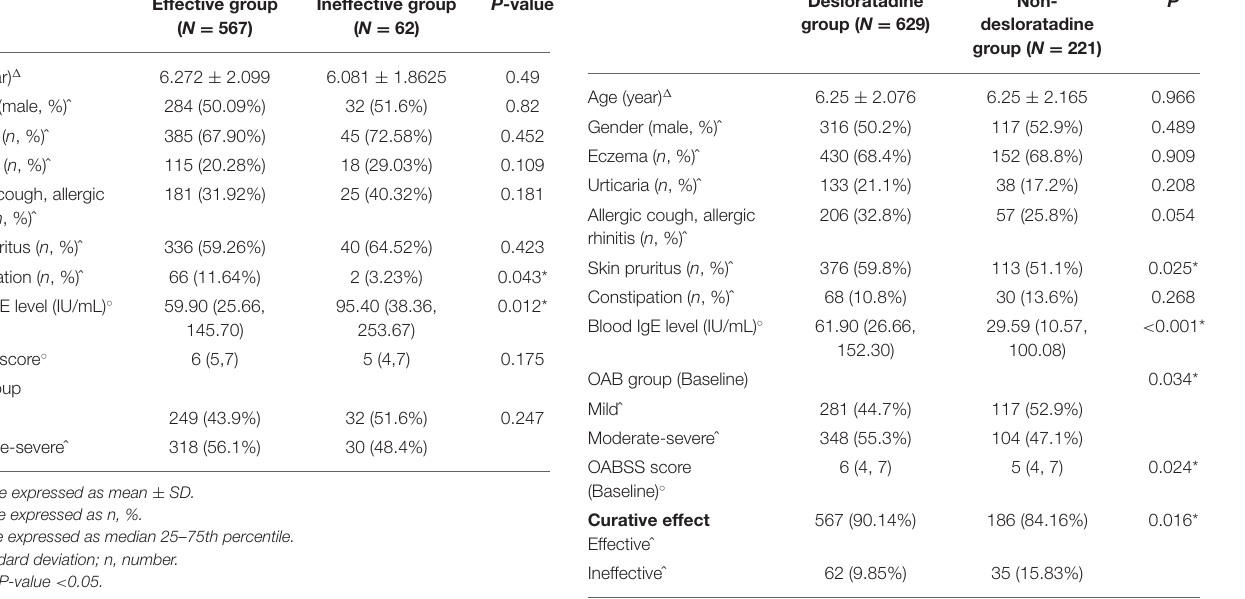
TABLE 7 | Comparison of related factors and efficacies of treatment with and without desloratadine. Desloratadine Non- group ( N = 629)